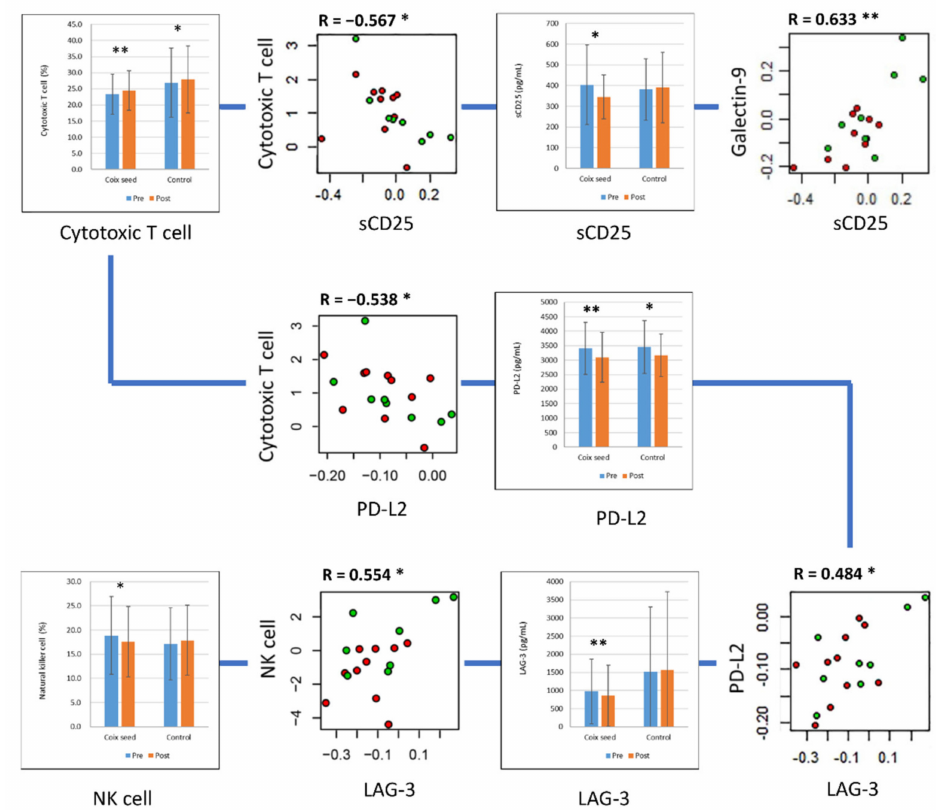
Figure 2. sCD25, PD-L2, and LAG-3 and their correlation with peripheral lymphocyte subset percent- ages. The plasma concentration of sCD25, PD-L2, and LAG-3 significantly decreased after coix seed consumption. The changes in sCD25 and PD-L2 showed a significant correlation with the changes in cytotoxic T cell percentage; sCD25 also showed significant correlation with plasma concentration of galectin-9. The change in LAG-3 showed a significant correlation with the changes in natural killer (NK) cell percentage and plasma concentration of PD-L2. In the scatter plots, the red and green circles denote the coix seed consumption group and the control group, respectively. In the bar graphs, the blue and orange bars denote before (pre-intervention) and after (post-intervention) coix seed consumption, respectively. *, p < 0.05; **, p <